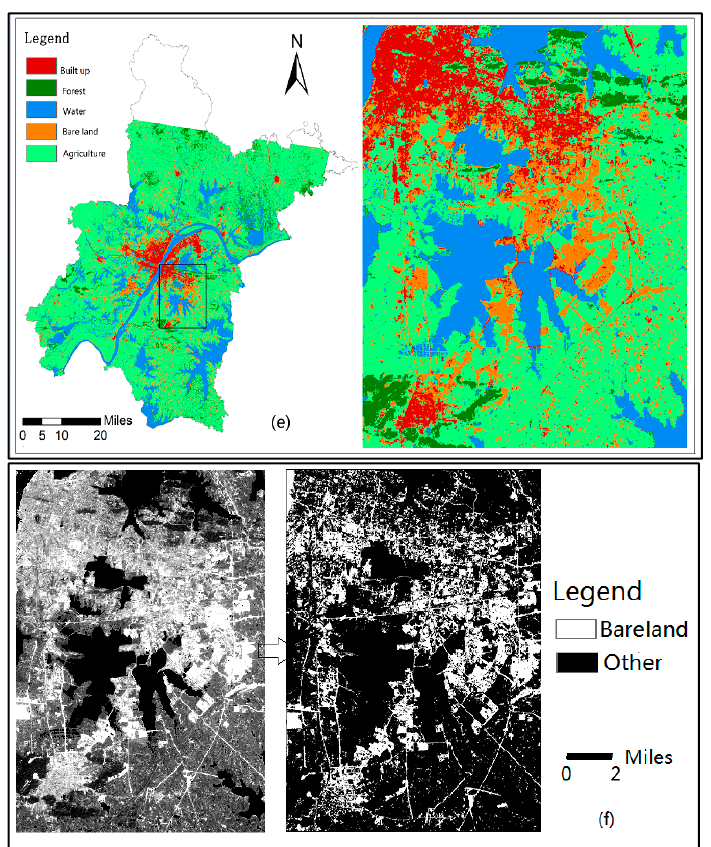
Figure 5. Unsupervised classification results: ( a ) MNDWI and extracted water in the subset; ( b ) water-masked NBLI and extracted bare land in the subset; ( c ) masked UI and extracted built-up in the subset; ( d ) masked inverse NBLI and the extracted forest and agriculture in the subset; ( e ) the combination of all LULC; and ( f ) comparison test, partial masked NBLI and extracted bare land with Ostu.